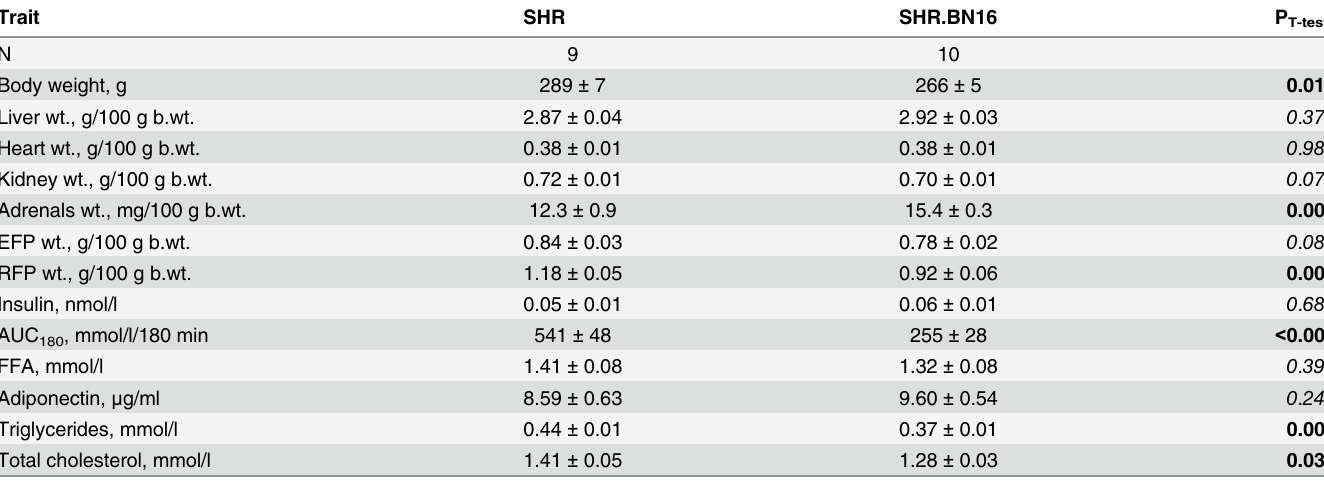
Table 1. Morphometric and metabolic profiles of SHR and SHR.BN16 congenic rats fed a standard